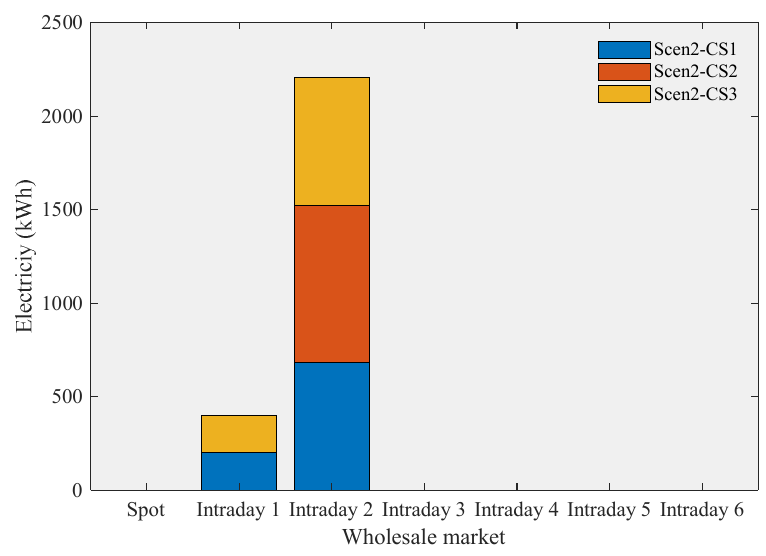
Figure 12. Accumulated electricity buy from the wholesale market.